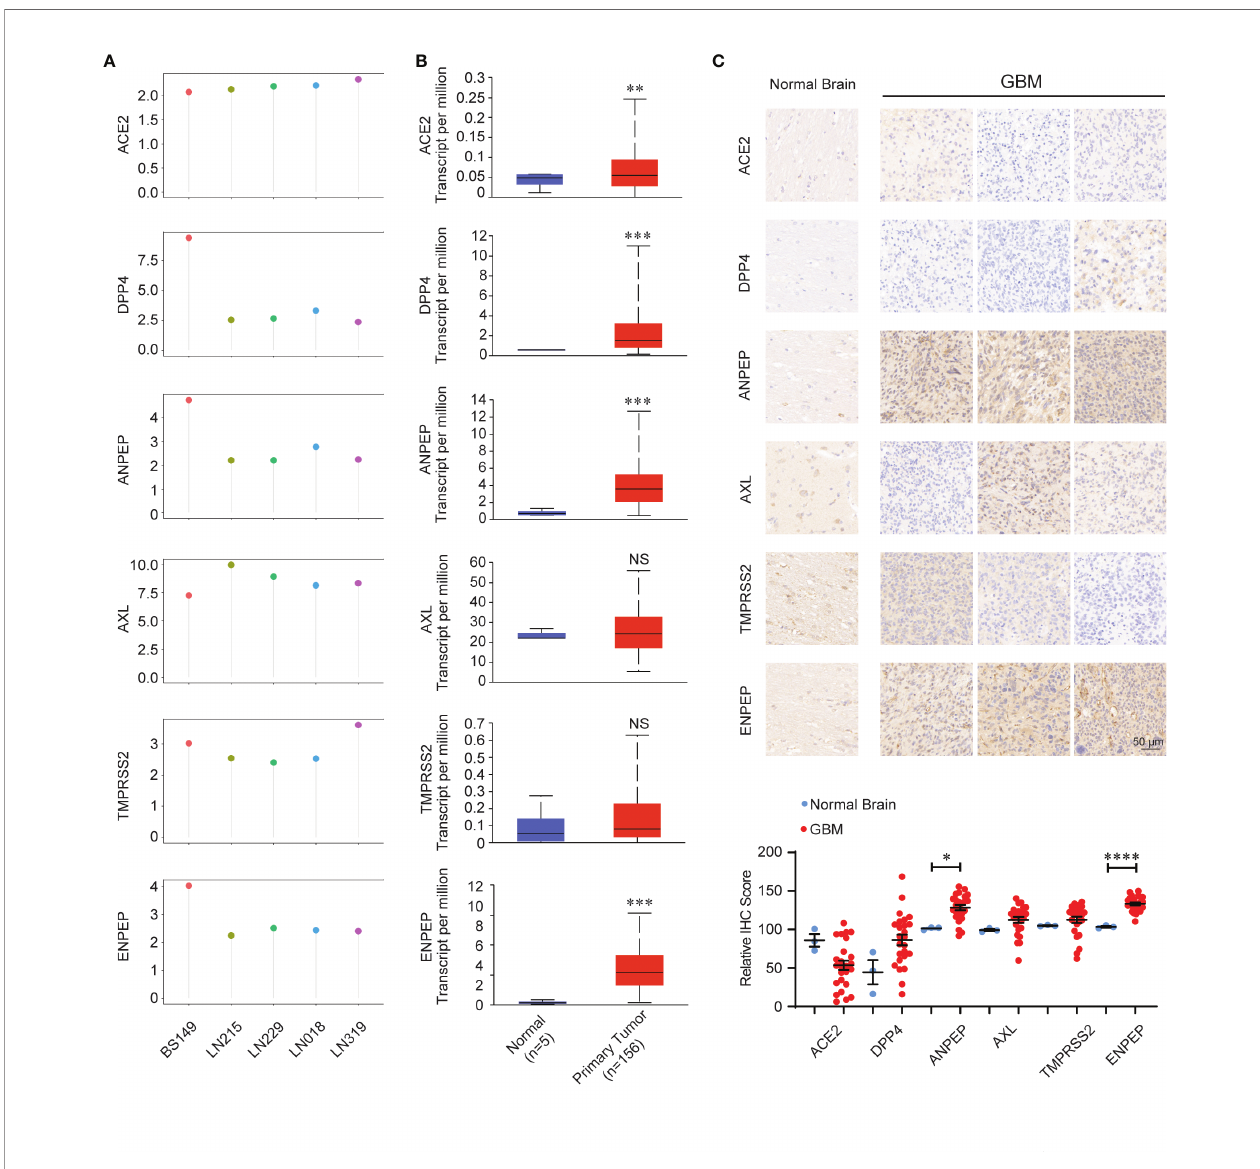
FIGURE 2 | Expression pattern of coronavirus receptors in glioblastoma multiforme (GBM). (A) CoV receptor mRNA in glioblastoma cell lines LN018, LN215, LN229, LN319, and BS149 (recurrent glioblastoma) from GDS4468. (B) Coronavirus receptor mRNA between normal (n = 5) and GBM (n = 156) tissues extracted from the TCGA database by the UALCAN program. (C) Representative images of immunohistochemistry images of receptors in normal (n = 3) and GBM (n = 27) tissue chips. (D) Histologic scores. Mean +SEM. Signi fi cance comparison is to normal people. Scale bar = 50 m m. *P < 0.05; **P < 0.01; ***P < 0.001; ****P < 0.0001, NS: no signi fi cance P >